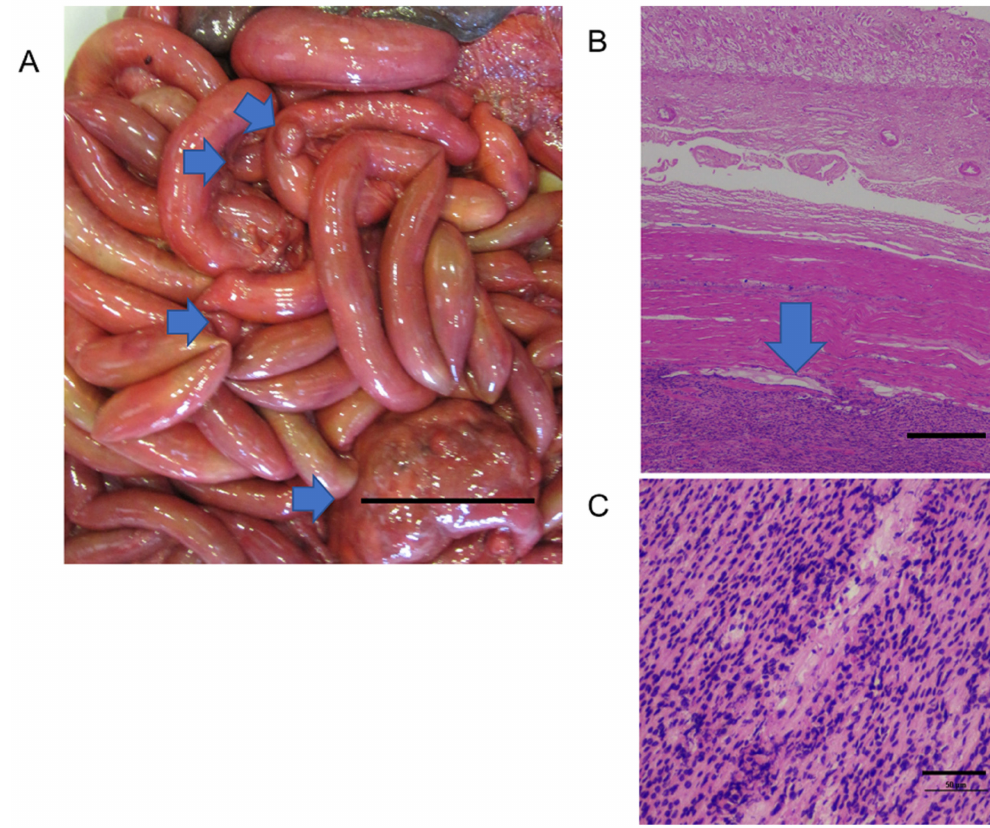
Figure 7. Adult female common dolphin ( Delphinus delphis ). ( A ) Intestine with numerous neoplastic nodules (blue arrows), scale = 5 cm. ( B ) Tumor cells (blue arrow) developed between the muscle layer and serosal membrane of the small intestine, scale = 100 µ m. ( C ) High magnification of the nodule showing mature spindle-shaped cells of a suspected stromal tumor, scale = 50 µ